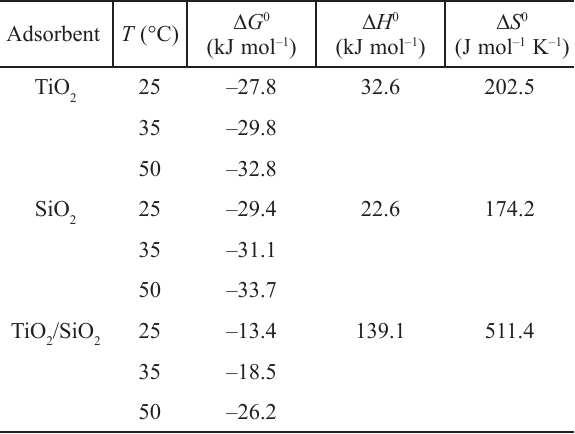
Table 3 – Thermodynamic parameters for cefdinir adsorp- tion on TiO , SiO , and TiO /SiO adsorbents (Adsorbent load- 2 2 2 2 ings = 0.1 g L –1 , pH = 4) Adsorbent T (°C)